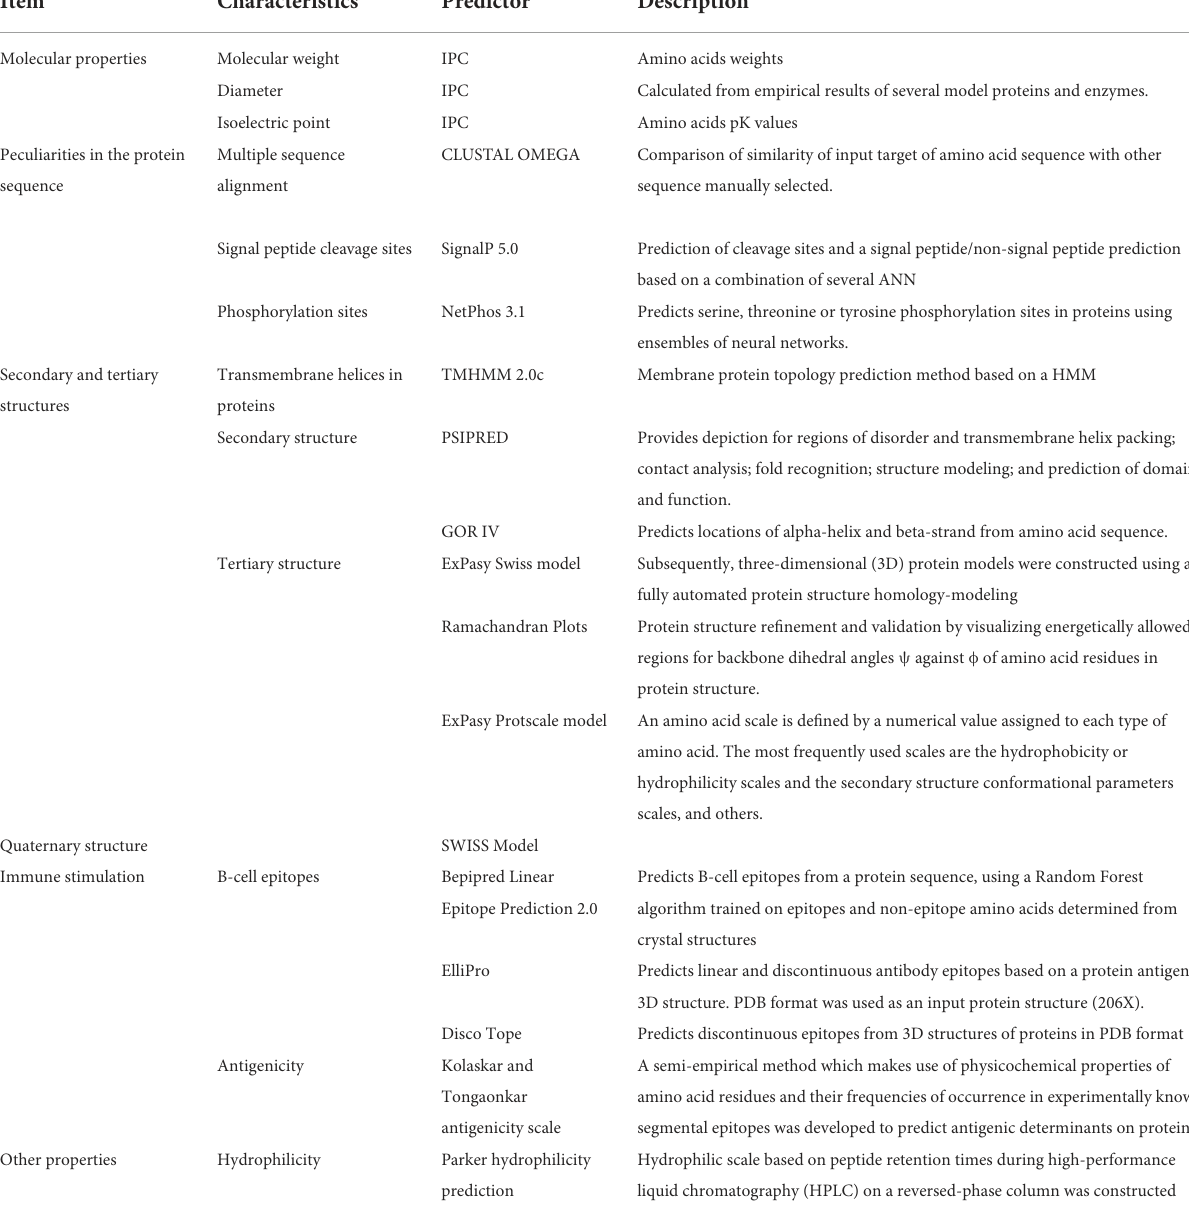
TABLE 1 Predictors used to analyze different features of FhCatL1